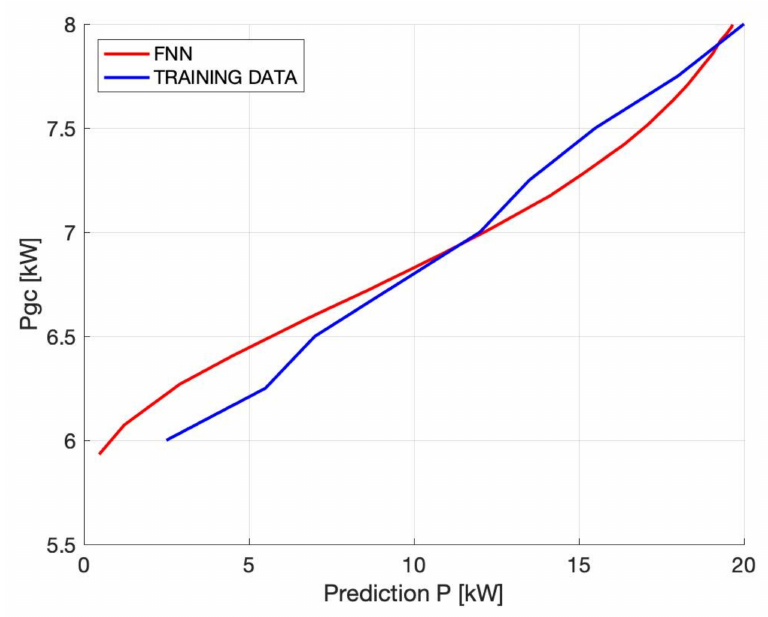
Figure 33. Compilation of the training data with the machine response, scenario 2.